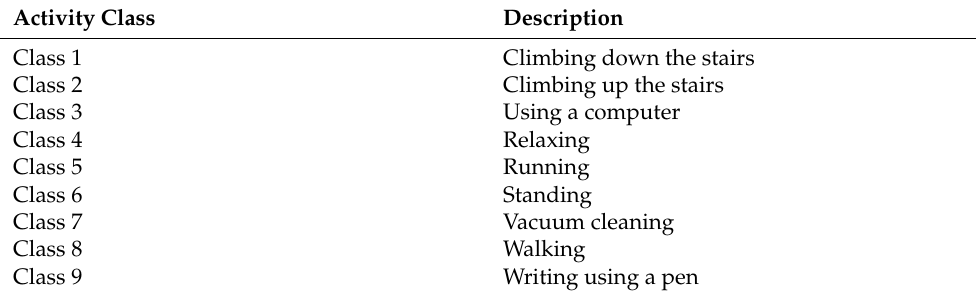
Table 1. The list and description of the measured